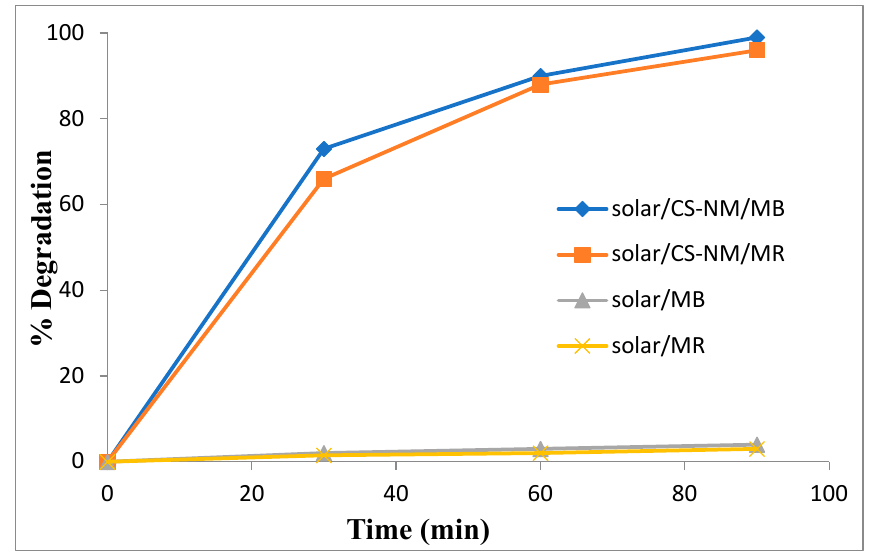
Figure 9. Degradation of MR and MB by solar/CS-NM and solar photolysis. [MB] 0 = [MR] 0 = 50 ppm, [CS-NM]0 = 0.5 g, pH = 10.